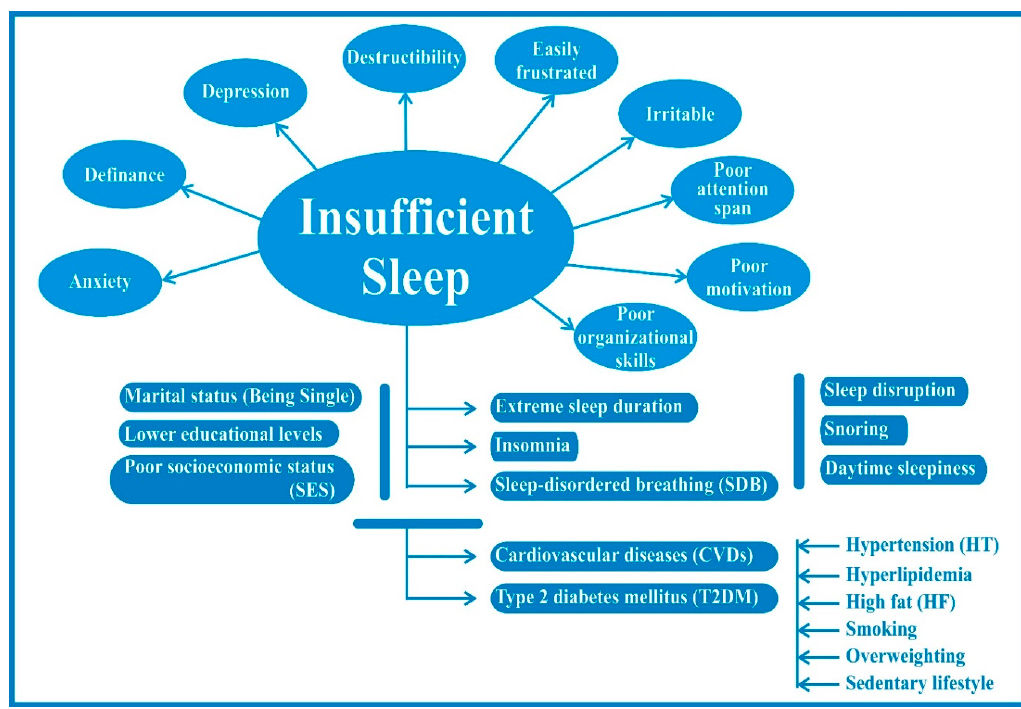
Figure 2. Insufficient sleep and its impact on the pathophysiology of the human body.